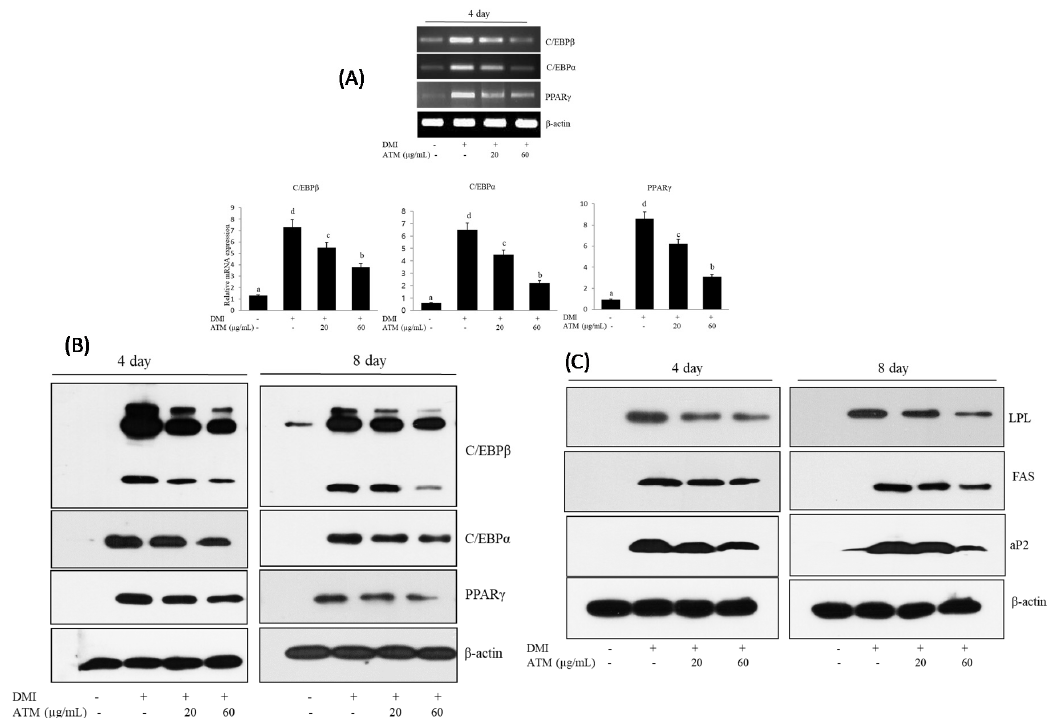
Figure 2. E ff ects of ATM on adipogenesis-related genes in 3T3-L1 adipocytes. ( A ) mRNA expression levels of C / EBP β , C / EBP α , and PPAR γ were measured in 3T3-L1 adipocytes on day 4 by reverse-transcriptase polymerase chain reaction (RT-PCR) analysis. Similar results were obtained by three independent experiments. Optical density analysis was performed to quantify the levels of mRNA expression with β -actin as the loading control. ( B ) The protein expression levels of C / EBP β , C / EBP α , and PPAR γ were measured in 3T3-L1 adipocytes by Western blot analysis. β -actin was used as the loading control. Bars with di ff erent letters are significantly di ff erent ( p < 0.05) as determined by Duncan’s multiple range test. ( C ) Adipogenesis- and lipogenesis-related gene expressions in 3T3-L1 adipocytes on days 4 and 8 as determined by Western blot